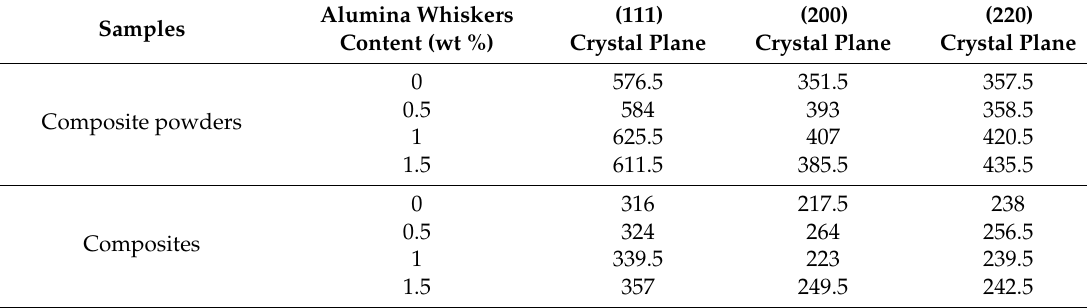
Table 3. Mean grain sizes of Cu composite powders and composite at different crystal planes.